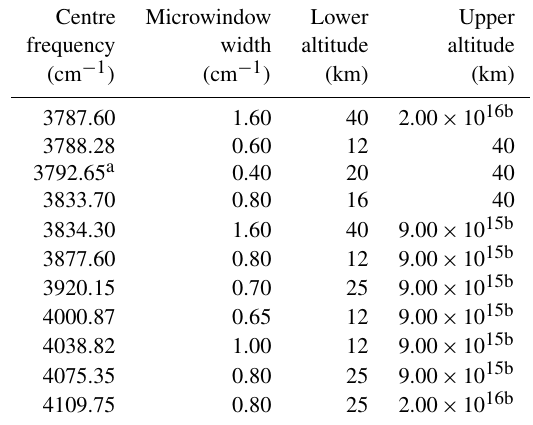
Table 1. Microwindows for the v3.0/v3.5 ACE-FTS hydrogen fluo- ride